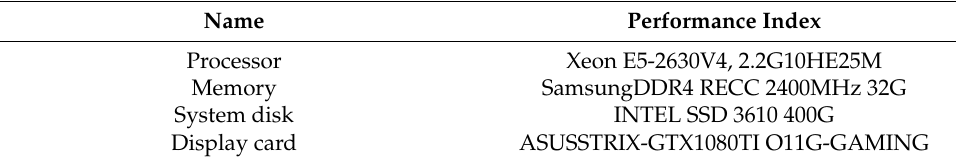
Table 2. Experimental